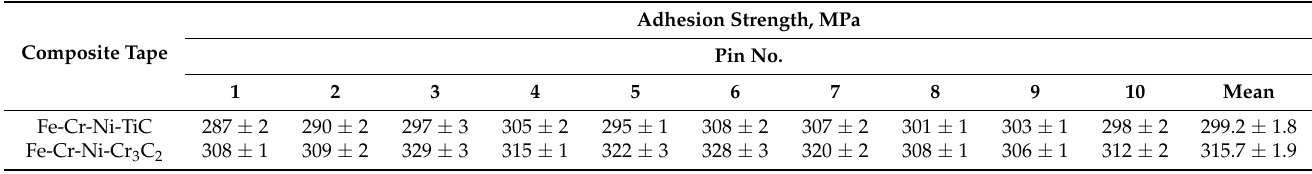
Table 2. The results of studies of the adhesion strength of tapes welded to specimens of steel